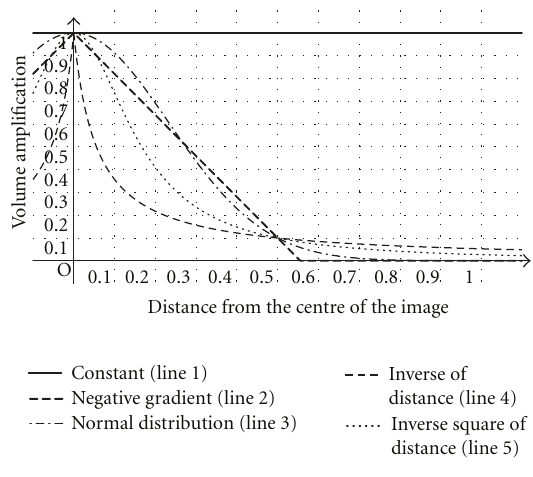
Figure 13: Mixing rate